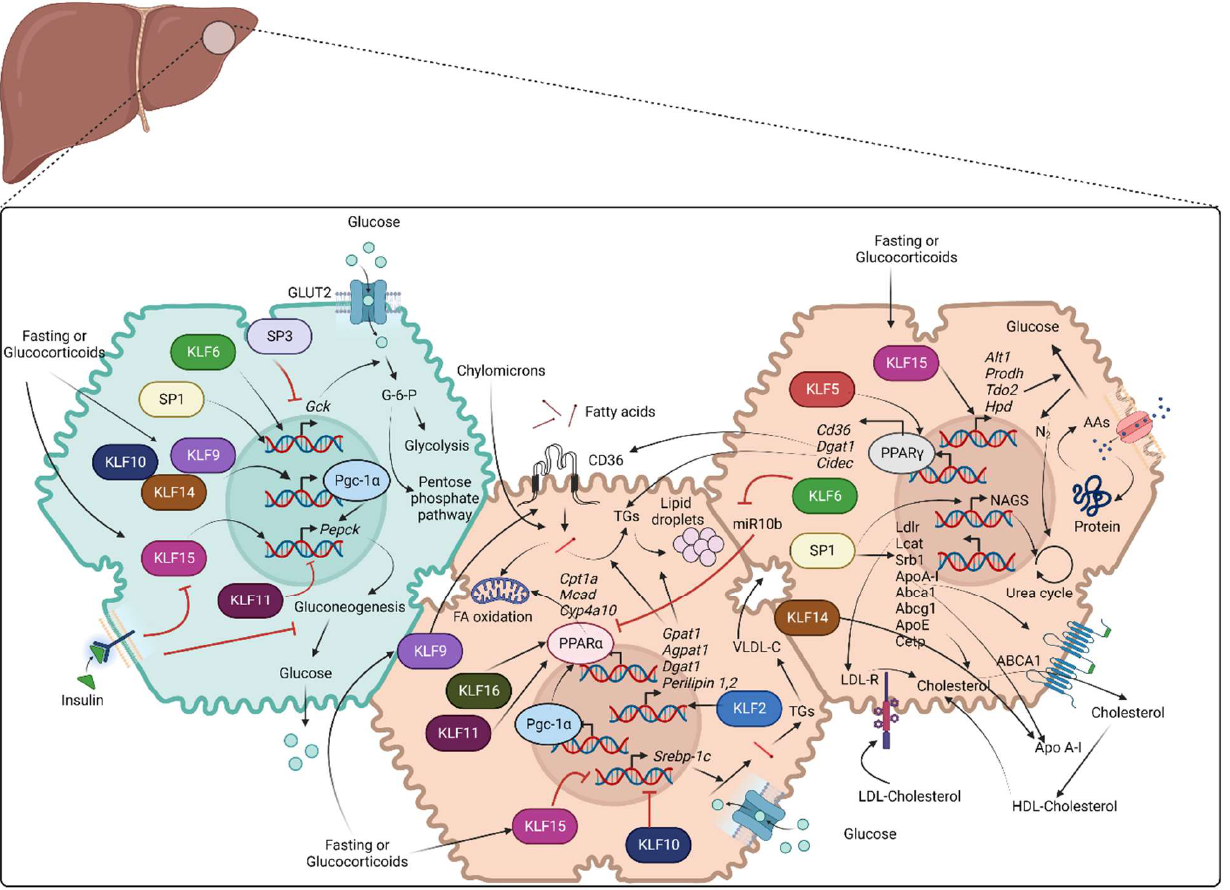
Figure 2. Role of SP/KLF transcription factors in metabolism: Green shade represents glucose metabolism, and brown shade represents lipid and amino acid metabolism. Glucose metabolism: Glucose enters hepatocytes through GLUT2 and is converted to glucose-6-phosphate with the contribution of the Gck enzyme. Glucose-6-phosphate further participates in glycolysis or pentose phosphate pathway. SP1 and KLF6 stimulate the transcription of Gck . Fasting or glucocorticoid stimulation induces KLF9, KLF10, KLF14, and KLF15. KLF9, KLF10, and KLF14 stimulate transcription of Ppargc1a , whereas KLF15 along with PGC-1 α , promotes the transcription of Pepck that encodes the rate-limiting step of gluconeogenesis, leading to increased hepatic glucose production. KLF11 suppresses gluconeogenesis via transcriptional repression of Pepck and Ppargc1a . Lipid metabolism: Fatty acid uptake is mediated by CD36 and is followed by TG storage in lipid droplets or β-oxidation in mitochondria. Hepatocytes carry out de novo lipogenesis from pyruvate and the synthesis of cholesterol that is secreted as a component of VLDL or HDL particles. SP1 stimulates the transcrip- tion of several genes that are important for cholesterol metabolism, including LDLR , LCAT , SRB1 , APOA-I , ABCA1 , ABCG1 , APOE , and CETP . KLF14 stimulates the transcription of APOA-I . KLF2 and KLF9 promote lipid uptake via transcription of Cd36 . KLF2 promotes the transcription of enzymes of TG synthesis and lipid storage ( Gpat1 , Agpat1 , Dgat1 , Perilipin 1 , Perilipin 2 ). KLF11 and KLF16 promote β-oxidation of fatty acids by facilitating PPARα-mediated transcription of Cpt1a , Mcad , Cyp4a10 , and Cyp4a14 . KLF6 indirectly stimulates PPARα-mediated transcription of Trb3 by suppressing transcription of miR10b. KLF10 and KLF15 suppress SREBP-1c-mediated hepatic lipogenesis. KLF5 promotes the transcription of genes for lipid uptake and metabolism ( Cd36 , Dgat1 , Cidec ) through PPARγ stimulation. Amino acid/protein metabolism: Hepatocytes obtain circulating AAs through transporters or from degraded protein/polypeptides and use their carbon backbone for gluconeogenesis. Ammonia released from this reaction is toxic and enters the urea cycle. SP1 enhances the transcriptional induction of NAGS, which is essential for the urea cycle. On the other hand, KLF15 encodes transcription of the enzymes Alt1 , Prodh , Tdo2 , and Hpd, which are essential for AA metabolism and, eventually, gluconeogenesis (AA: Amino acids, Abca1: ATP binding cas- sette subfamily A member 1, Abcg1: ATP binding cassette subfamily G member 1, Agpat1: 1-acyl- sn-glycerol-3-phosphate acyltransferase alpha, Alt1: Alanine aminotransaminase 1, Apo A-I: Apolipoprotein A-I, ApoE: Apolipoprotein E, Cetp: Cholesteryl ester transfer protein, Cidec: Cell death-inducing DFFA-like effector C, Cpt1a: Carnitine palmitoyltransferase 1A, Cyp4a10: Murine